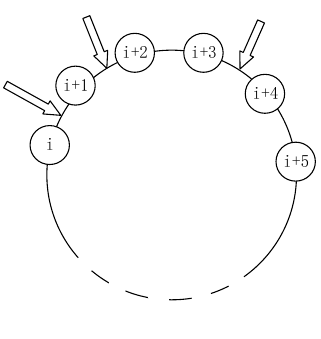
Figure 4. Attacking mode 2.